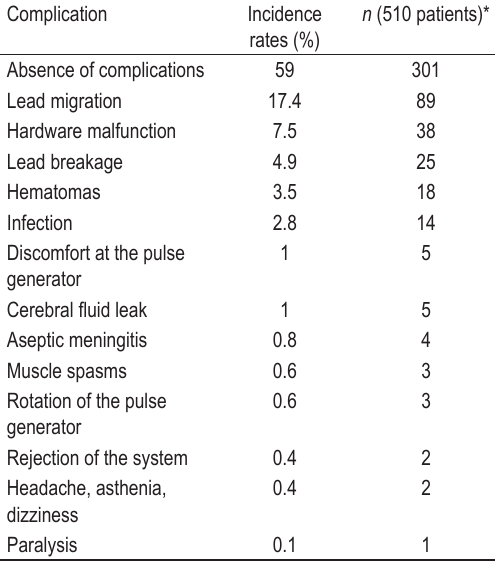
TABLE 3. Long-term complications rates of SCS